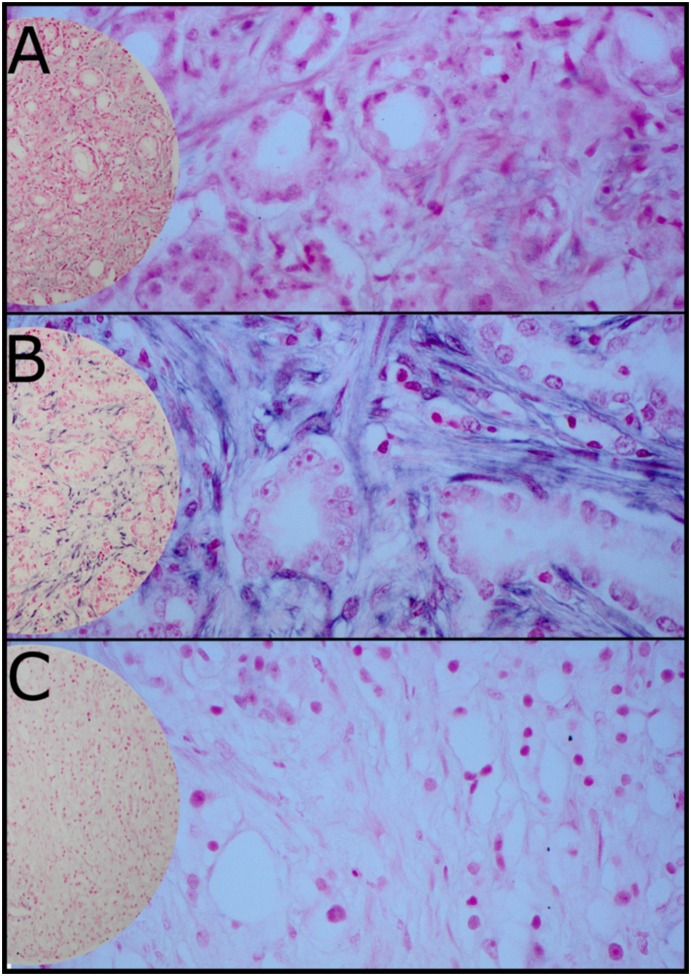
In situ hybridization (ISH) analysis of prostate cancer representing Gleason Grade (GS) <7 (A), GS 7 (B) and GS<7 (C), (200x and 400x magnification).